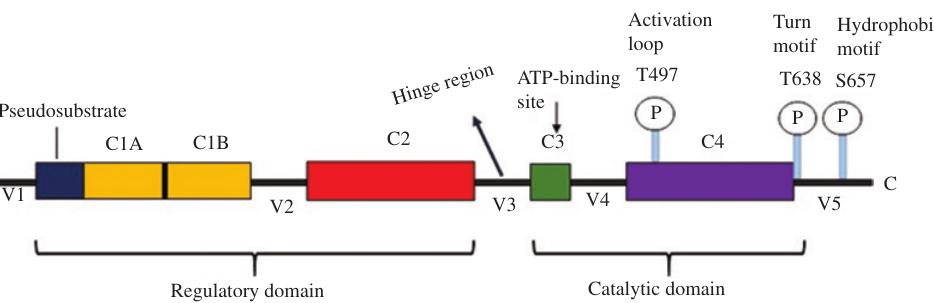
Figure 1: Diagrammatic representation of the domain composition of PKC- α showing four conserved domains and five variable domains. Conserved domains are: C1 (yellow) responsible for DAG binding, Ca 2 + -coordinating domain C2 (red). PKC- α comprises conserved catalytic domains C3 (green) and C4 (purple) recognized as ATP and the substrate-binding site, respectively, and pseudosubstrate (blue) which main- tains the PKC- α in an inactive conformation. V3 acts as a hinge region which connects the regulatory domain to the catalytic domain and proteolytically hydrolyzes during apoptosis by